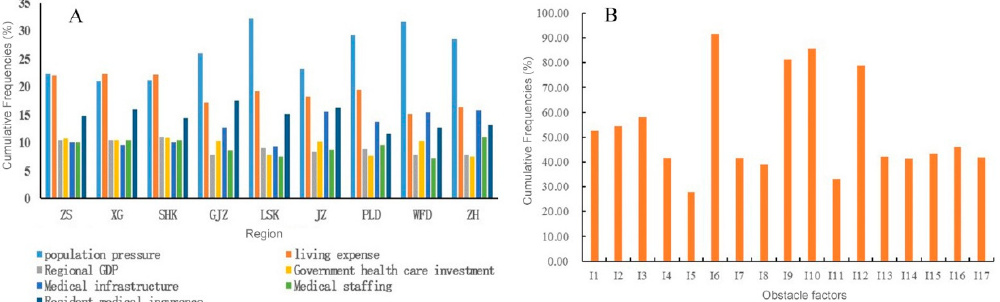
Figure 3. Frequency of obstacles and cumulative frequency histogram of obstacles in various regions. ( A ) Contribution of indicators by region; ( B ) Cumulative frequency of index obstacle degree.